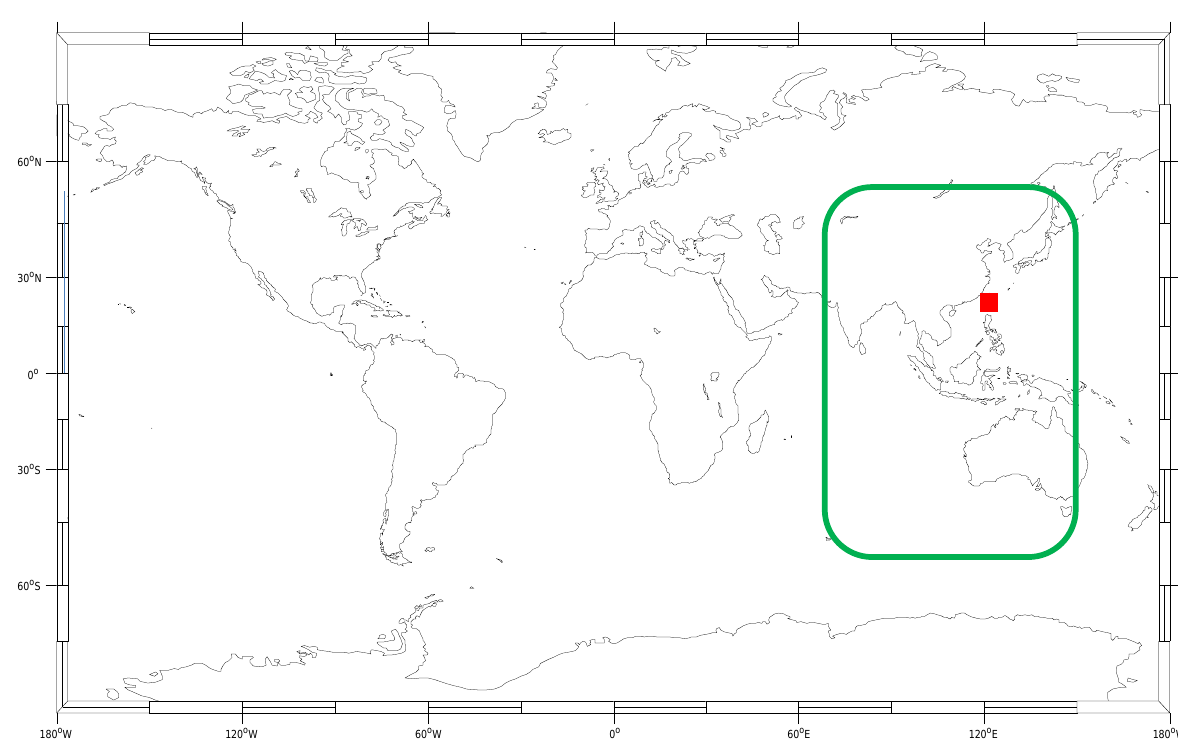
Figure 1. BDS service